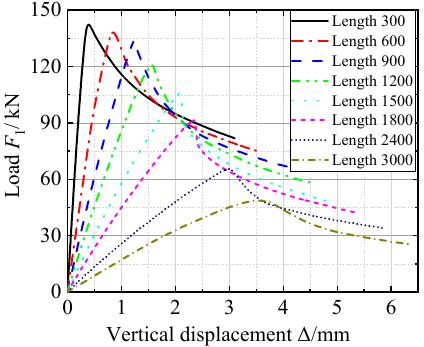
Figure 9. F - Δ relationship curves of C120-40-15-1.5- L.